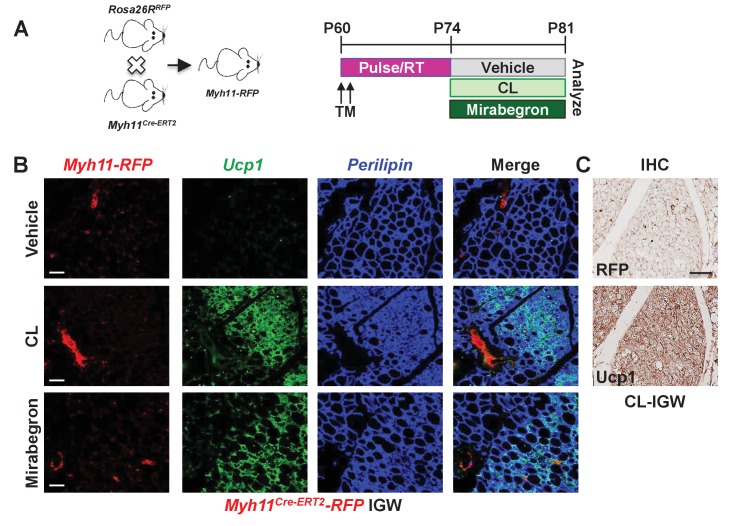
Myh11+ smooth muscle cells are not a source of Adrb3 induced beiging.(A) Illustration of mice and experimental regime: two-month-old Myh11Cre-ERT2; RosaR26RFP male mice were administered one dose of TM for two consecutive days. Two weeks post TM, mice were randomized to vehicle, CL or mirabegron for seven days (n= 6/group). (B) Representative images of fate mapping analysis of Myh11Cre-ERT2-RFP+ cells into Ucp1 [Ucp1 (green) and perilipin (blue)] beige adipocytes within IGW depots from mice described in (A) Scale bar = 100 µm. (C) Representative RFP and Ucp1 IHC of IGW depot sections from mice described in (A) treated with CL for seven days. Scale bar = 100 µm.